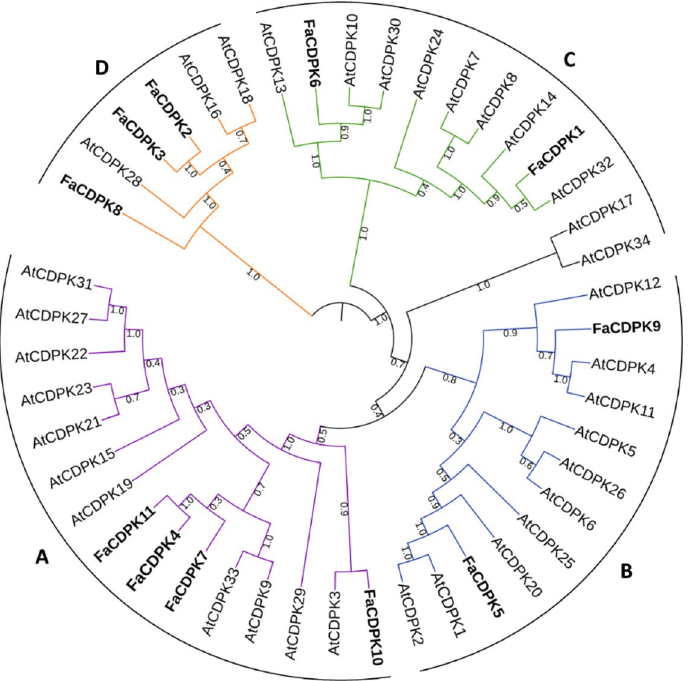
sequence alignment using Neighbor-Joining method with p -distance and bootstrap analysis (1,000